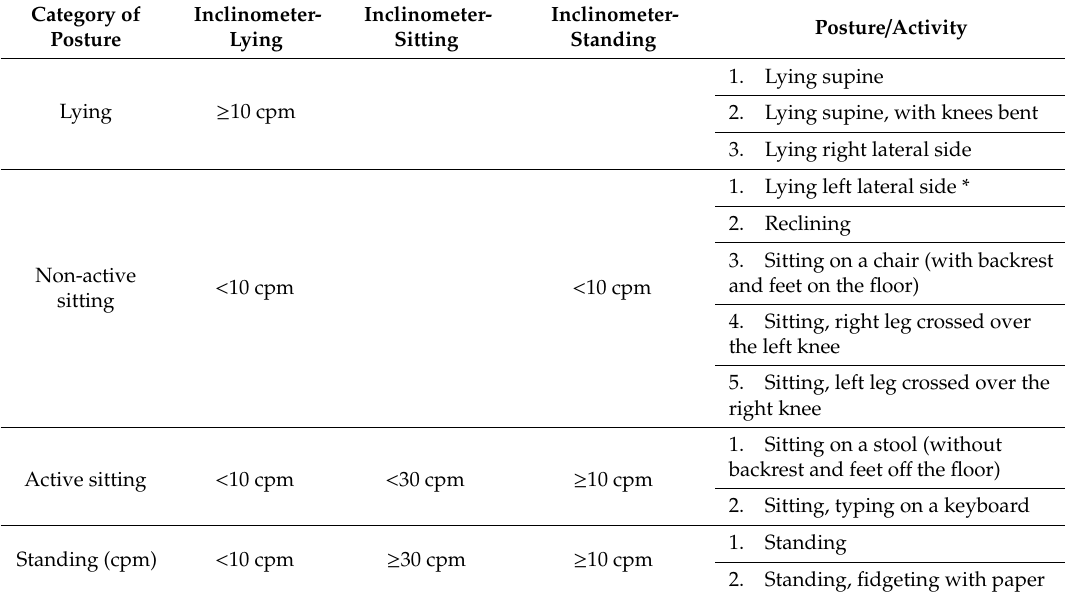
Table 1. Classification of sedentary postures / activities into four